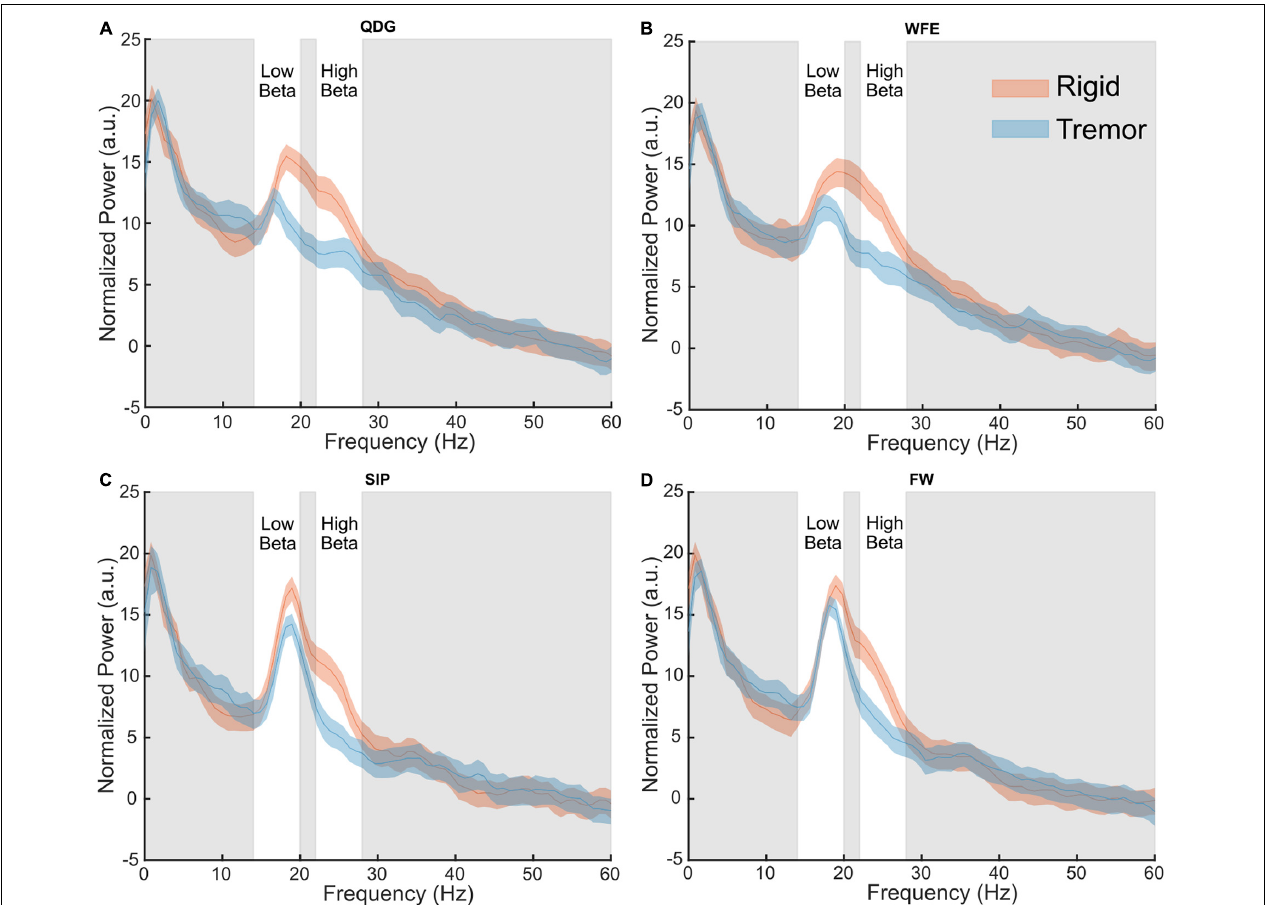
FIGURE 4 | Grand average normalized power spectral density plots for each phenotype in the (A) QDG, (B) WFE, (C) SIP, and (D) FW tasks. There were significant differences ( p < 0.05) between phenotypes in the high beta band.